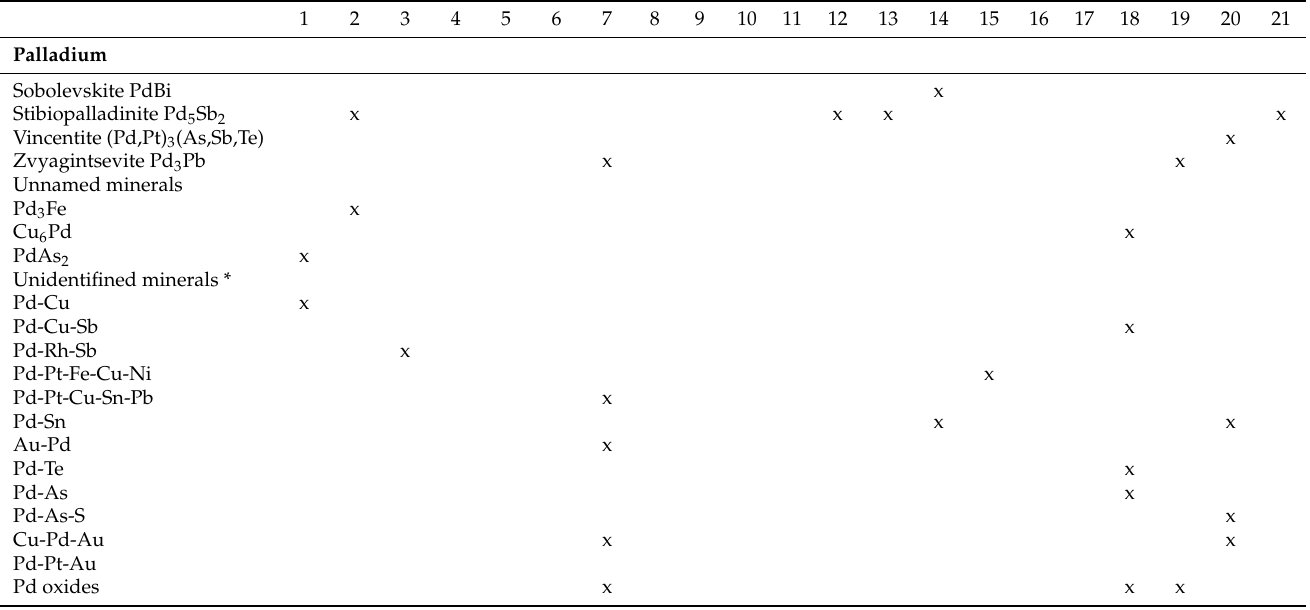
Figure 5. Back-scattered electron images of PPGM from selected the PPGE-rich ophiolitic chro- mitites. ( A ) Composite and polygonal inclusion of Pt-Fe alloy, and silicate pyrrhotite in unaltered chromite from Nurali [51]; ( B ) grain composed of osmium and Pt-Fe alloy in contact with chlorite and chromite from Loma Peguera [21]; ( C ) Pt-Fe alloy found in the chromitite of Sebuku showing a porous texture, irregular shape and zoning, in the contact of chromite and chlorite [59]; ( D ) second- ary PGM of Pt-Pd-Cu and Pt-Pd sulfide associated with garnet and chlorite in altered chromite of Nurali [51]; ( E ) composite grain consisting of potarite, Pt-Cu alloy, pentlandite, chalcopyrite, mag- netite and chlorite, in altered chromite of Nurali [51]; ( F ) altered PGM in contact with chlorite from the Newfoundland chromitites [26]; ( G ) irregular and tiny grains of sperrylite in the contact between chlorite and pentlandite in the Moa Baracoa chromitites [29]; ( H ) antimonide of Pd and Cu associ- ated with millerite in contact with altered chromite and silicate of Al‘Ays chromitite [50]; ( I ) second- ary Pt 6 Cu alloy in the altered matrix of Al‘Ays chromitite [50]; (J) Pt-Fe alloy in contact with serpen- tine found in the Korydallos chromitite [47]; ( K) complex grain composed of Pt-Ni, Pt-Cu alloys, sperrylite and Ni-arsenide associated with chromite and altered silicate, Korydallos chromitite [45]; (L) secondary Pt-Ni alloy in contact with Ni-Fe alloy in the altered matrix on the Korydallos chro- mitite [45]. Abbreviation: Sil = silicates, Chr = chromite, Pn = pentlandite, Pt-Fe = Pt,Fe alloys, Chl = chlorite, Os = osmium, Grt = garnet, Pt-Pd-S = Pt,Pd sulfide, Pt-Pd-Cu = Pt,Pd,Cu alloy, Ptr = potarite, Pt-Cu = Pt,Cu alloy, Ccp = chalcopyrite, Mag = magnetite, Pd-Sb = Pd antimonide, Pd-Rh-Sb = Pd,Rh antimonide, Rh-Pd-Sb = Rh,Pd antimonide, Pt-Cu-Ni = Pt,Cu,Ni alloy, Spy = sperrylite, Pd-Cu-Sb =